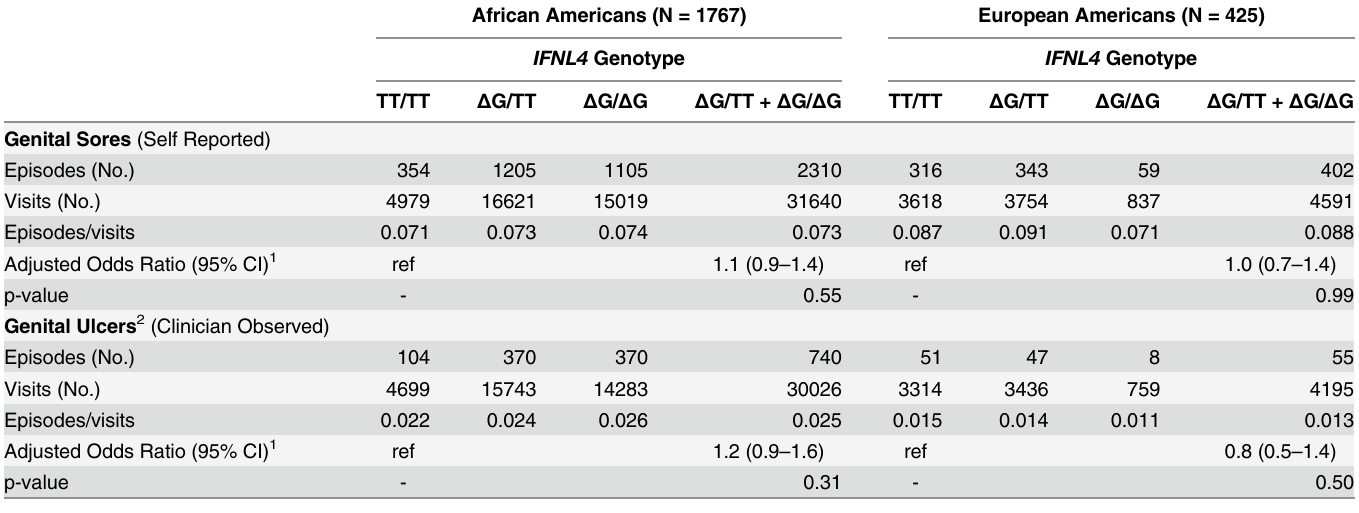
Table 4. Self-reported and clinician-observed episodes of genital herpes among women enrolled in WIHS (both cohorts), by IFNL4 genotype and race.